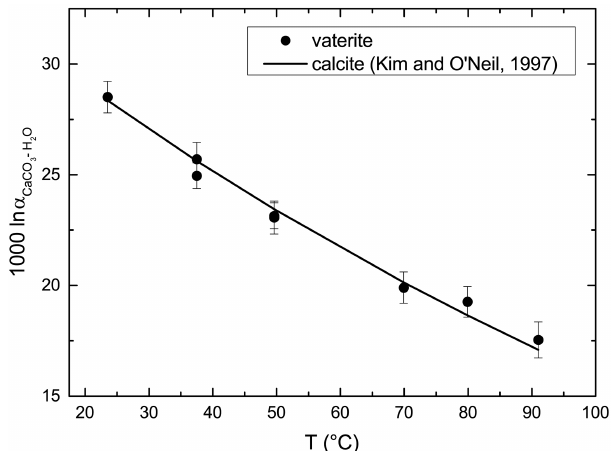
Figure 8. X-ray diffraction pattern of crystals from laboratory ex- periments. The experiment at 80 ◦ C produced a mixture of calcite, aragonite and vaterite (lower panel). For comparison, the XRD pat- tern of pure calcite is shown (upper panel). This example shows calcite that precipitated at 25 ◦ C from a pure CaCO 3 supersaturated solution without NaCl addition. The peaks in the lower panel are labelled according to the related mineral structure (A: aragonite; C: calcite; V: vaterite).